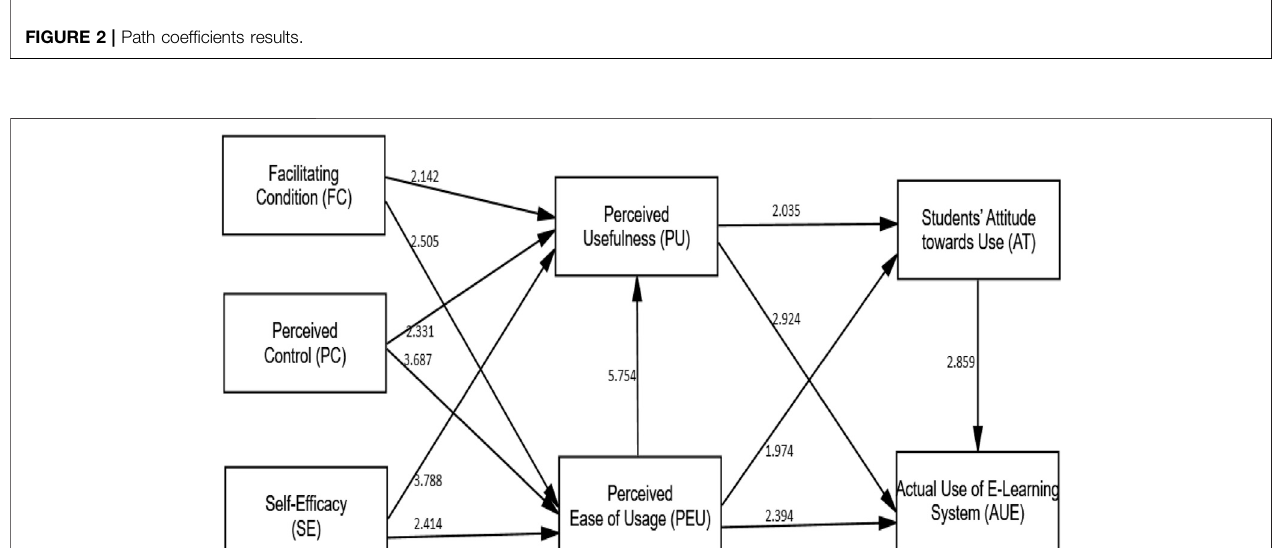
FIGURE 3 | Hypothesis